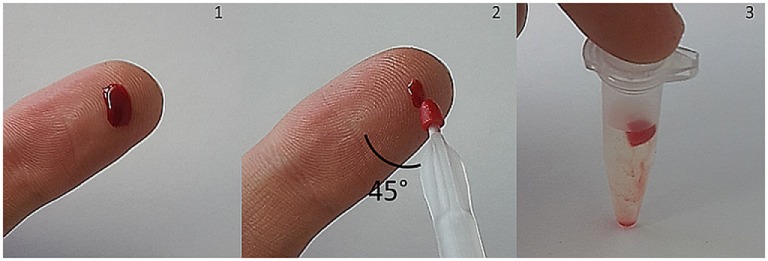
Blood collection with volumetric absorptive microsamplers (VAMS) after index finger puncture. Approximately 10 μL of whole blood are absorbed by the microsampling device. After drying at room temperature, VAMS can be stored at −20°C with desiccant or removed and suspended for analysis.